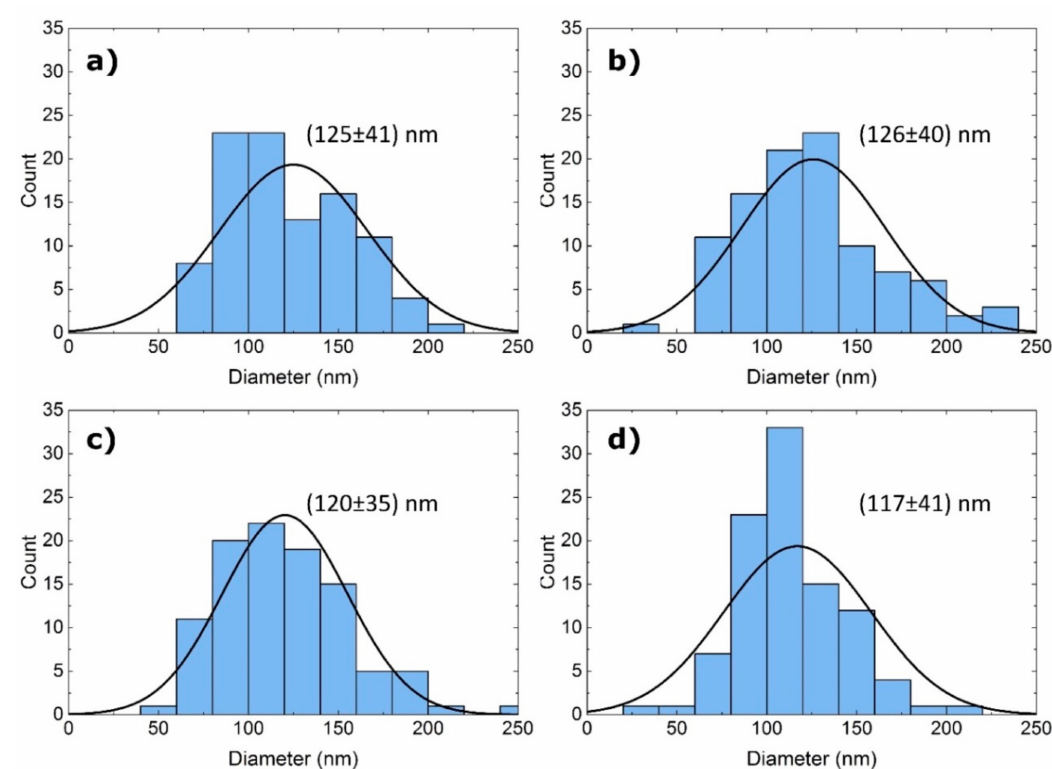
Figure 4. Diameter distributions of the nanofibers on ( a ) Ag–Cu flakes/graphite, ( b ) carbon black/PEDOT:PSS, ( c ) TiO 2 /ITO and ( d ) TiO 2 /PET.